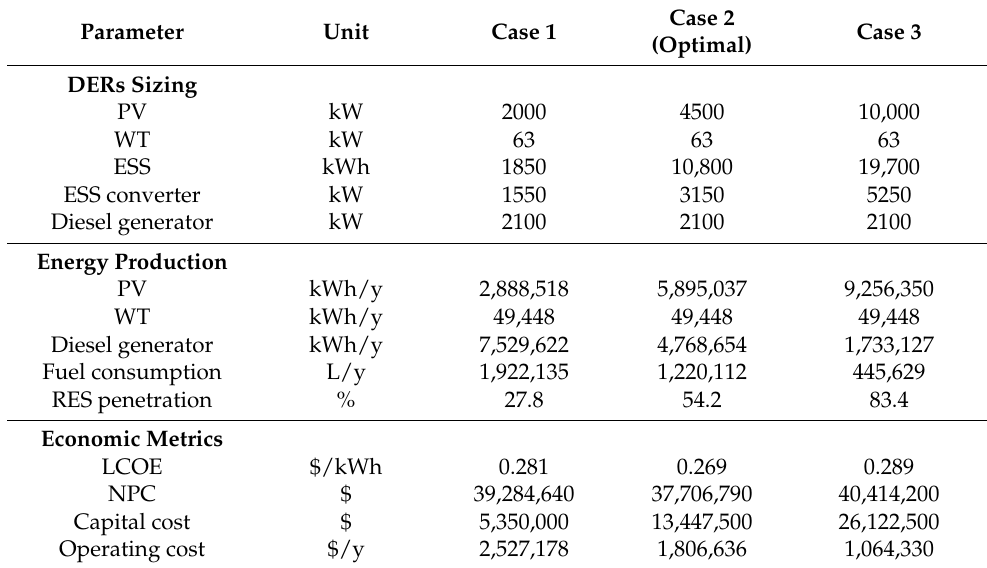
Table 6. Results of selected cases for Deokjeok Island microgrid considering power system reconfigu-